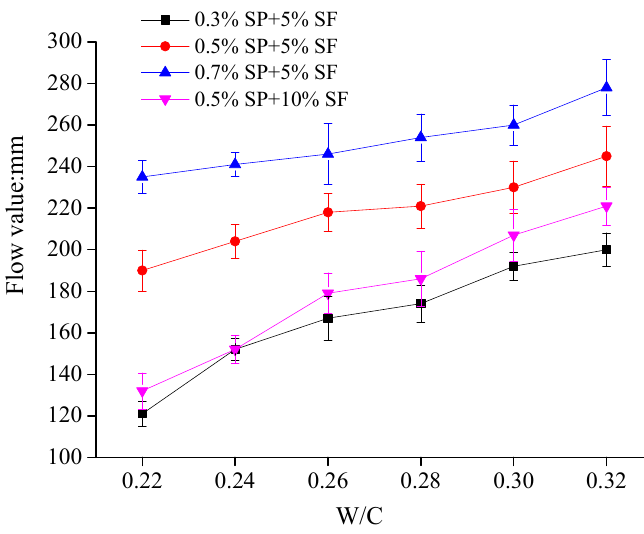
Figure 3. Flow values of pastes with different W/C (water cement ratio). Two to three pastes were prepared for each mix design and the figure shows an average of these together with the standard deviation.